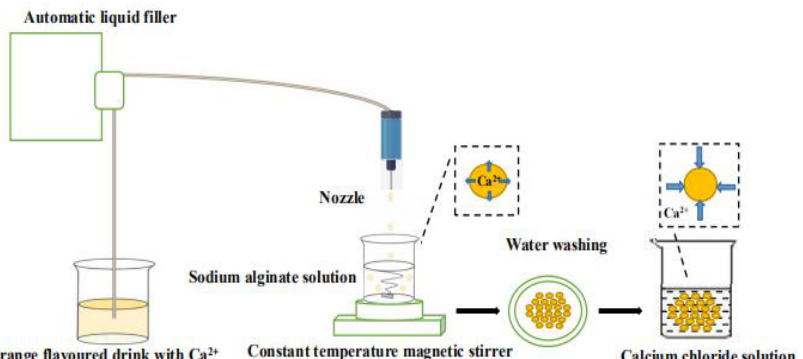
Figure 1. Schematic diagram of “boba” ball preparation.